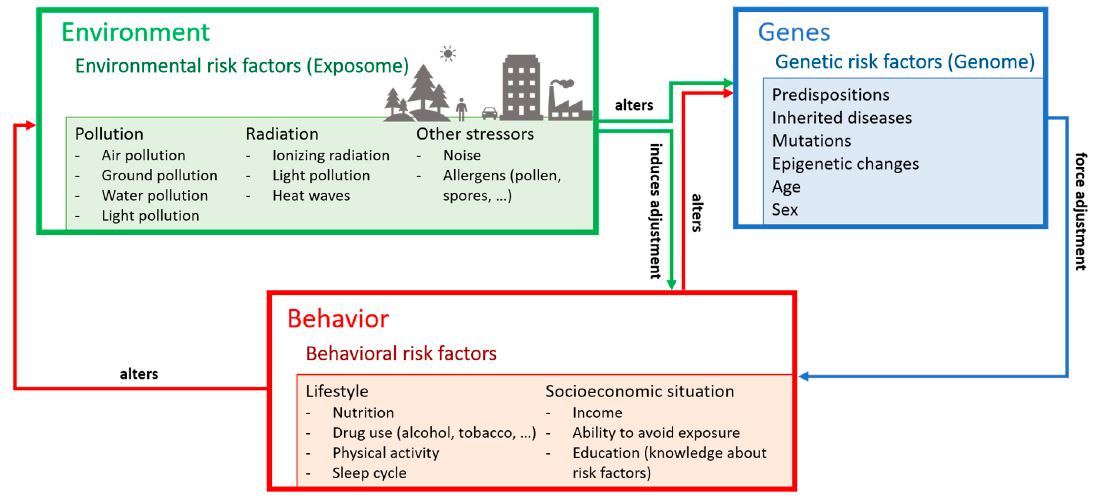
Figure 1. Risk factor spheres influencing non-communicable disease (NCD) susceptibility.